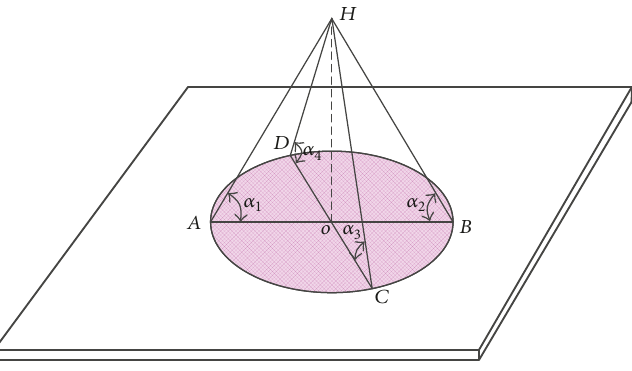
Figure 3: Schematic of measurement of angle of